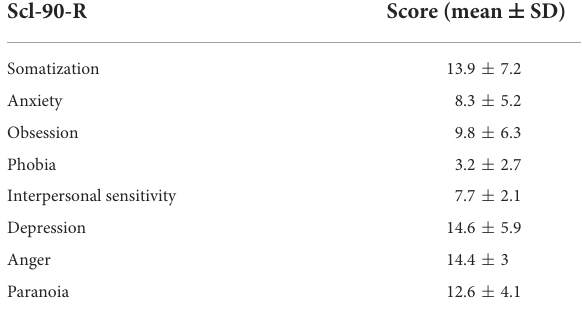
TABLE 1 Scl-90-R scores in patient diagnosed with affective